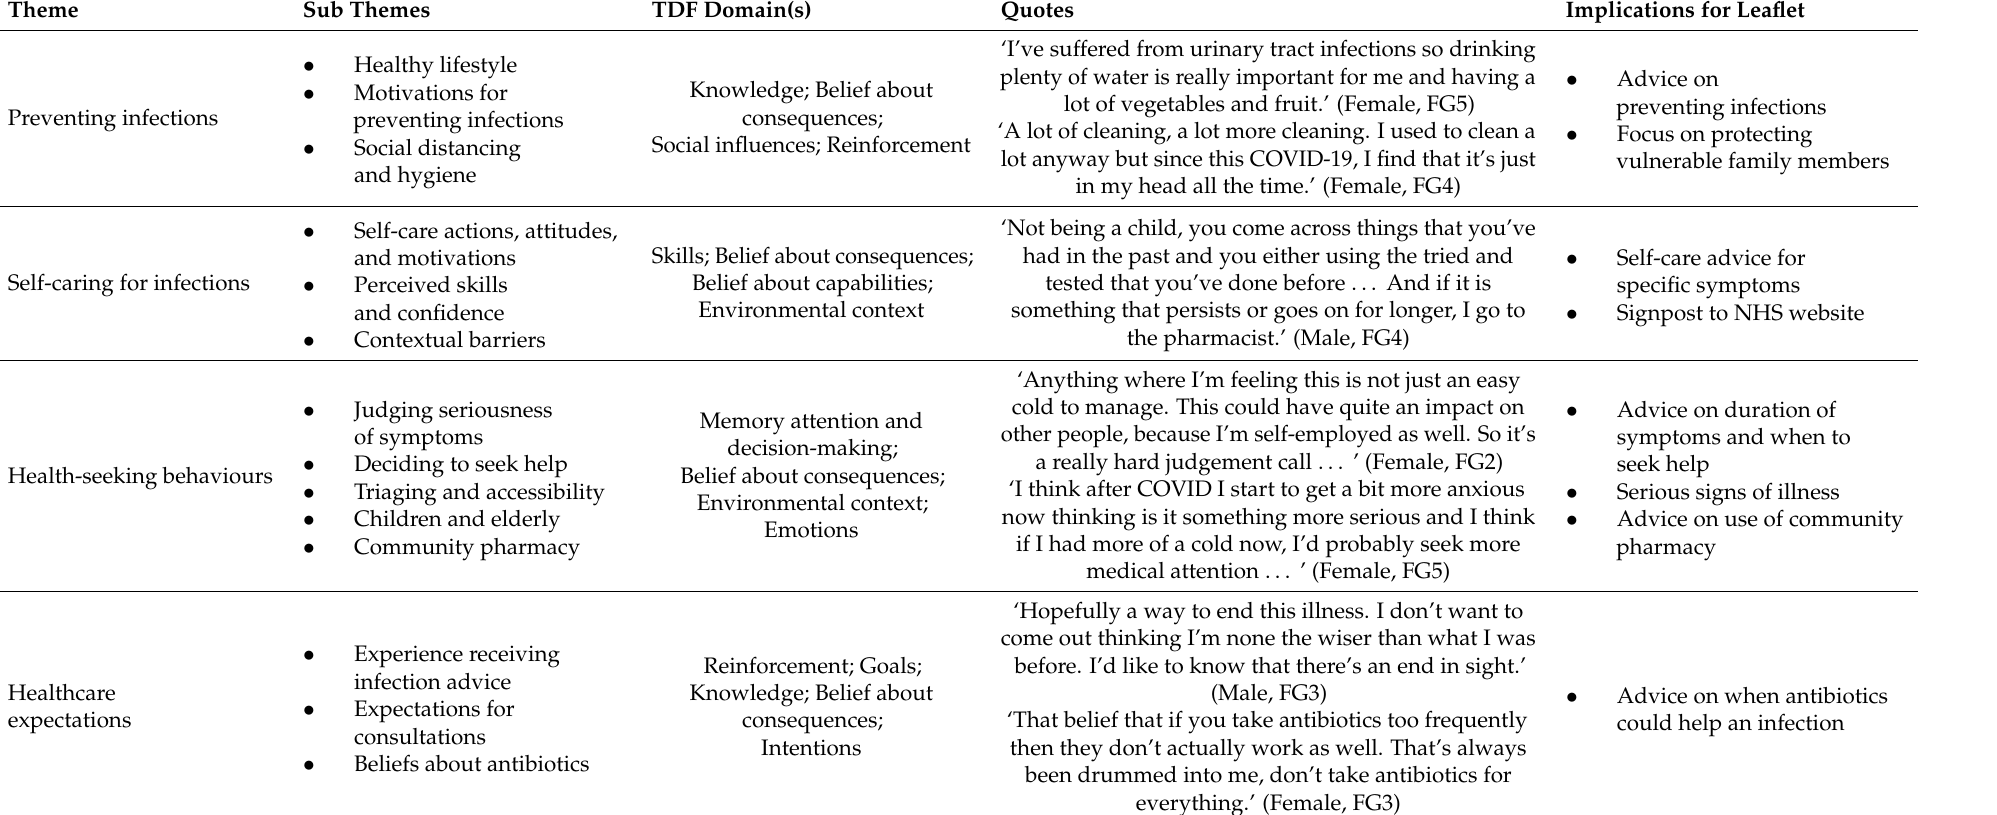
Table 2. Emerging themes of patients on self-management of common